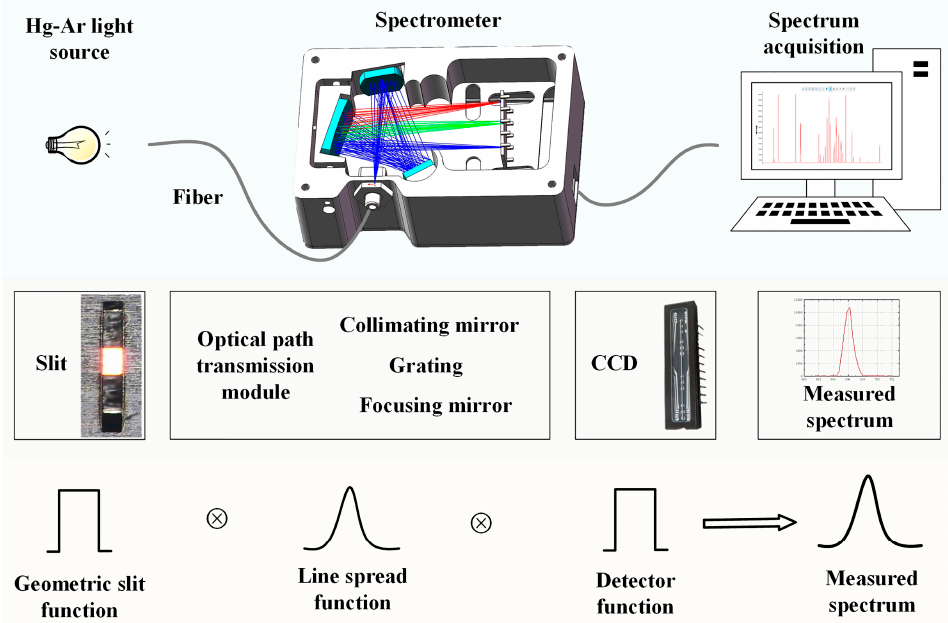
Figure 1. Influence of slit width, optical path transmission module, and detector on the C-T spec- trometer and convolution model. CCD—charge coupled device.